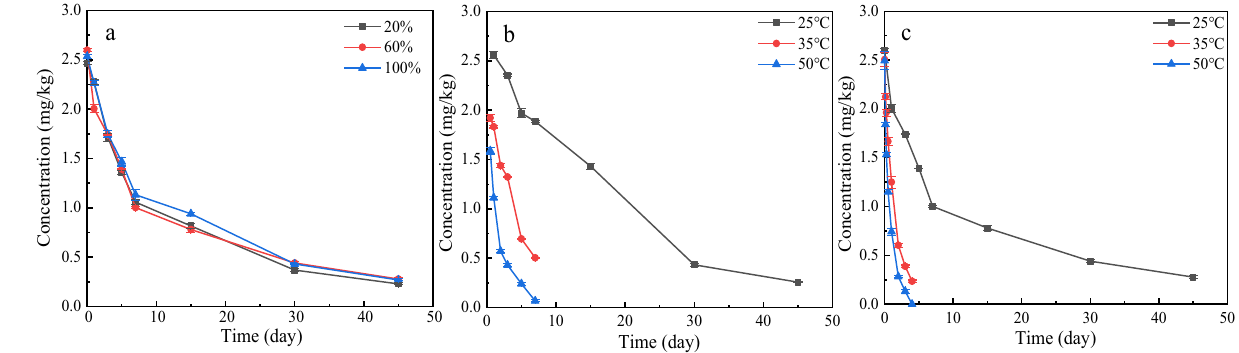
Figure 7. Propaquizafop degradation in ginseng soil under different conditions (( a ) different moisture content; ( b ) sterilised soil at different temperatures; ( c ) unsterilised soil at different